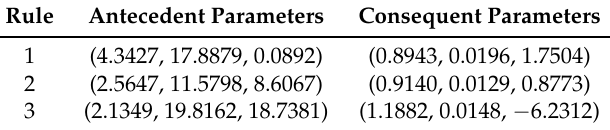
Table 1. Identified parameters of IT2 fuzzy system.